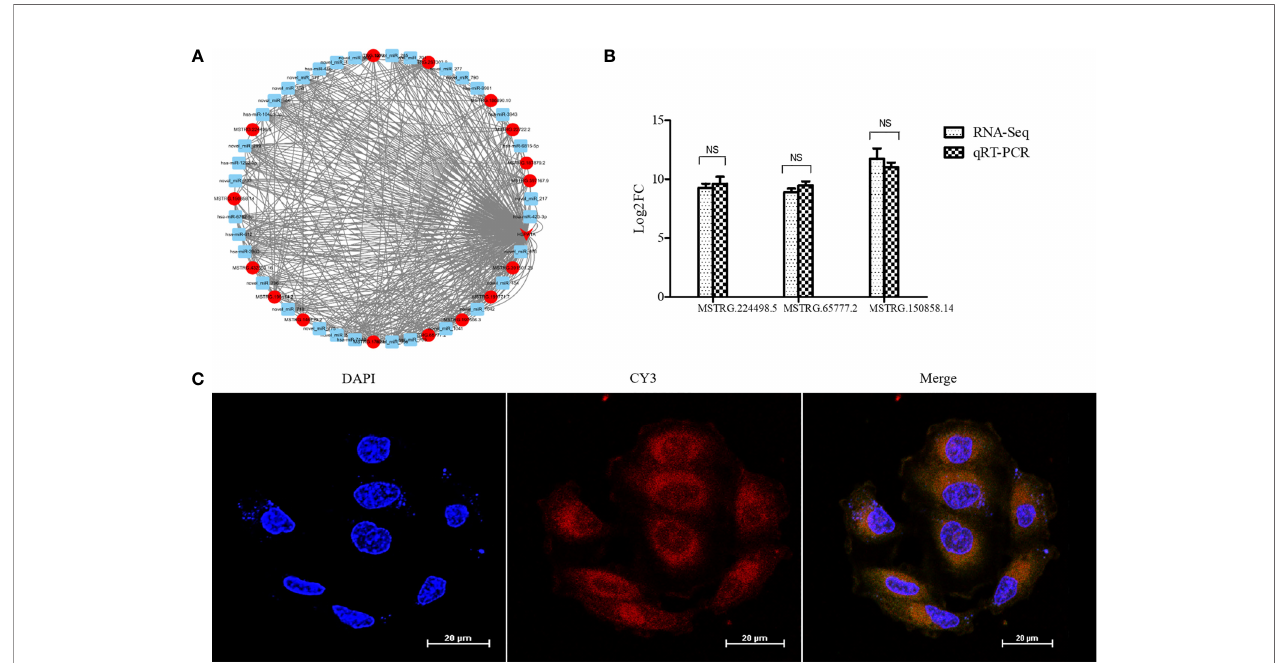
FIGURE 3 | LncRNAs NONHSAT079852.2 targets mRNA HSPA1A and is highly expressed in recurrent GBM and main located in Cytosol. (A) The ceRNA network construction of lncRNAs, miRNA and HSPA1A. lncRNAs is indicated by a circle. mRNA is indicated by an arrow. miRNA is indicated by a square. The up-regulated genes are indicated in red, while the genes with insigni fi cant changes are indicated in blue. (B) The comparison of qRT-PCR and RNA-seq detection of lncRNAs expression levels in the recurrent GBM and primary GBM. (C) Fish experiment demonstrated that the LncRNA NONHSAT079852.2 was mainly distributed in the cytoplasm of glioma cells. The results are presented as mean ± SD. NS, not signi fi